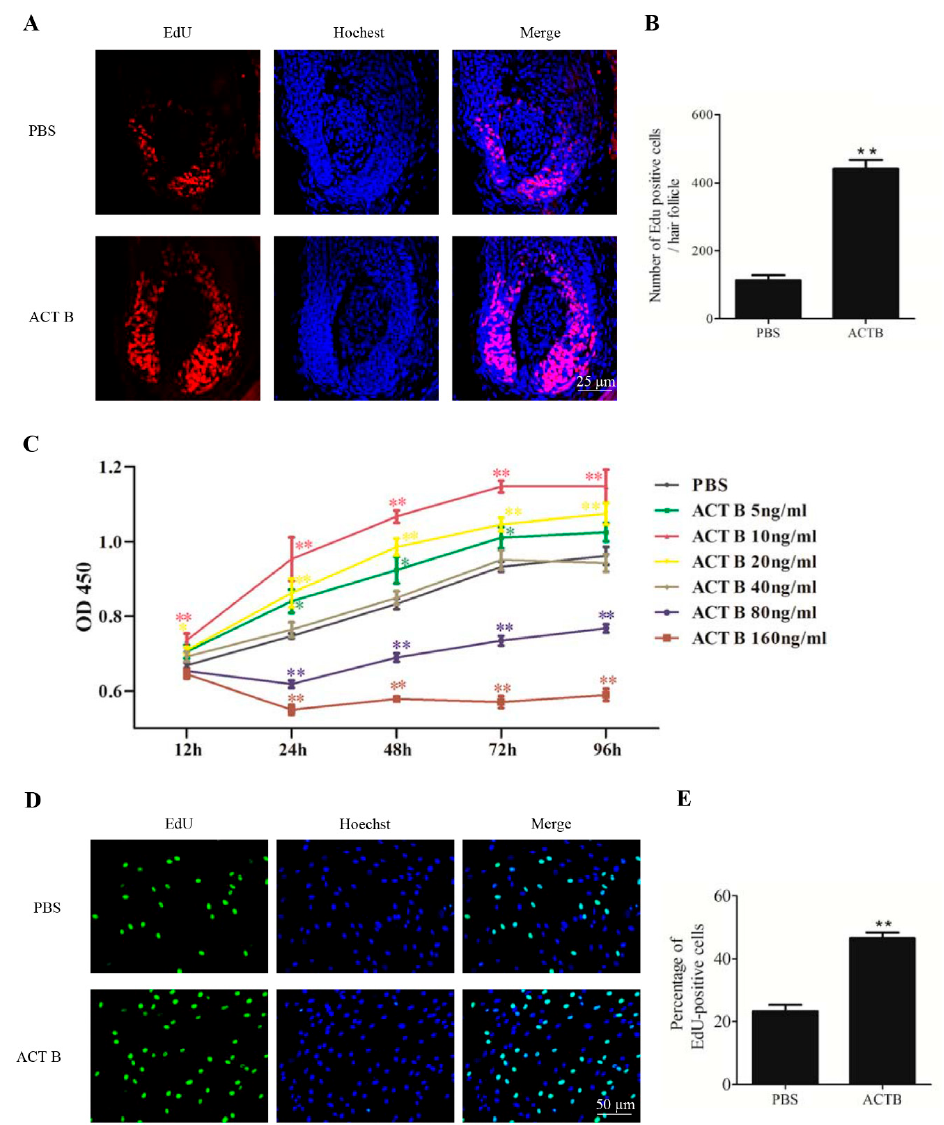
Figure 2. Activin B enhanced the proliferation of hair matrix cells in vivo and in vitro. ( A ) Representative images of EdU staining (red fluorescence) of vibrissae follicles treated with PBS or 10 ng/mL Activin B at 10 days after treatment. Nuclei were counterstained with Hoechst 33342 (blue fluorescence). ( B ) Ten vibrissae follicles per group were collected from five mice in each group and the number of EdU-positive cells in the two groups was counted. ( C ) Human hair germinal matrix cells (HHGMCs) were treated with Activin B at the concentration of 5, 10, 20, 40, 80, or 160 ng/mL. The CCK-8 assay was performed at 12, 24, 48, 72, and 96 h after treatment. ( D ) HHGMCs treated with 10 ng/mL Activin B or PBS were subjected to EdU assay (green fluorescence). Nuclei were counterstained with Hoechst 33342 (blue fluorescence). ( E ) The number of positive cells was counted manually in ten fields-of-view randomly selected from each well. The percentages of positive cells were calculated. * p < 0.05; ** p < 0.01, compared with the PBS group. Three independent experiments were conducted per data point. All error bars indicate